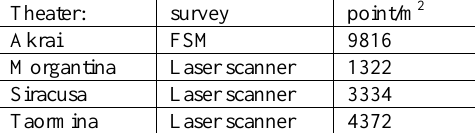
Table 3. In comparison the density of the points of the clouds in the different survey.